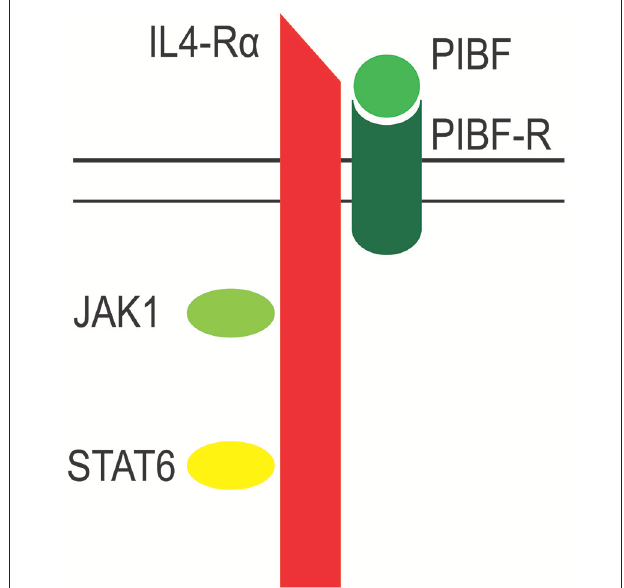
FIGURE 3 | The structure of the PIBF receptor. The receptor for PIBF is a GPI anchored protein. After PIBF binding the receptor associates with the alpha chain of the IL-4 receptor. This initiates intracellular signaling, via the Jak/STAT